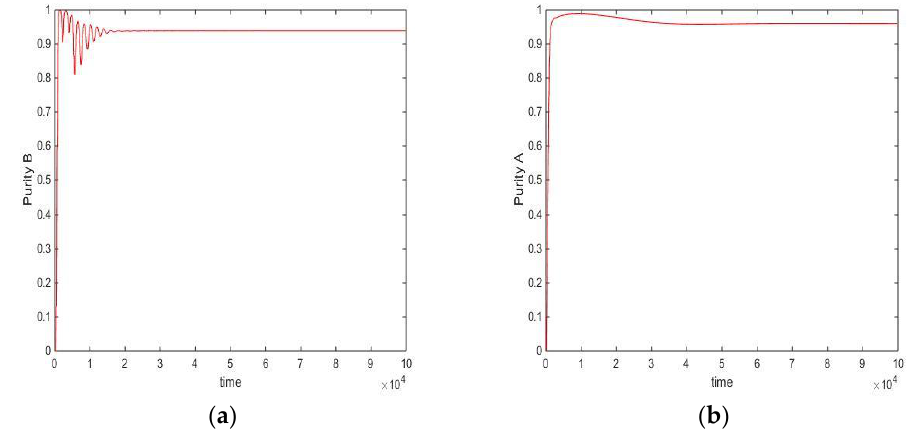
Figure 8. Control results of the second experiment (switch time = 180 s; desired A = 96%, desired B = 94%). ( a ) Extraction outlet (material B); ( b ) raffinate outlet (material A).